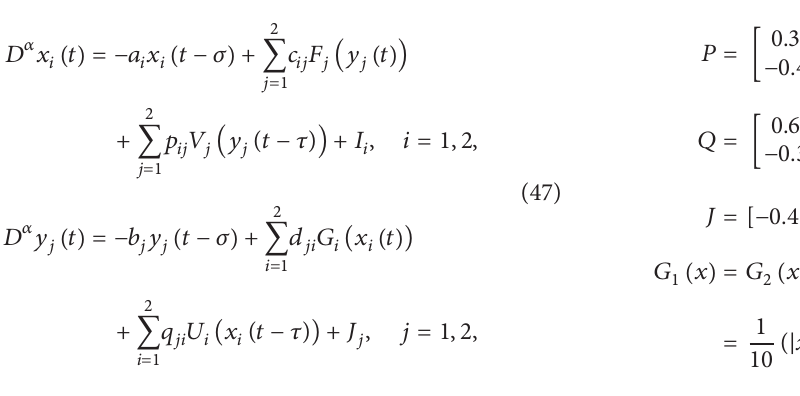
𝑇 = (−6.5, −7.0, 7.5, 8.0)